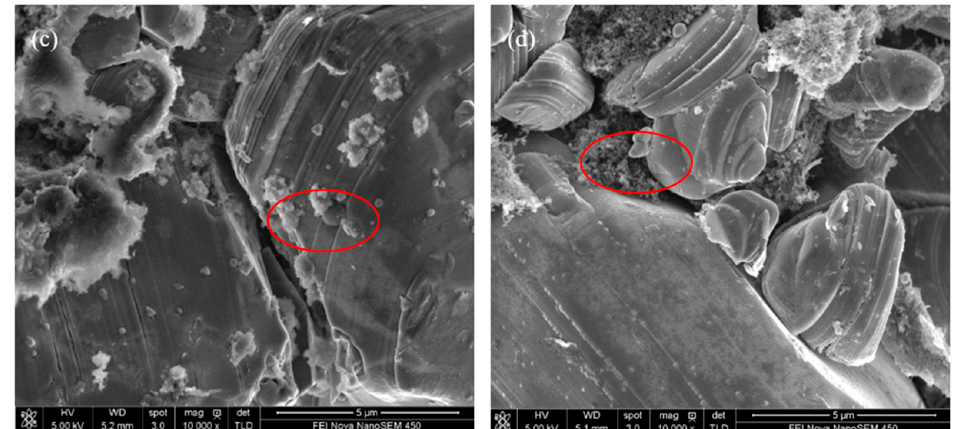
Figure 6. SEM images of LiCoO 2 cycled with a base electrolyte: ( a ) After the first cycle and; ( b ) after 600 cycles; SEM images of LiCoO 2 cycled with the electrolyte containing 0.5% TAIC; ( c ) after the